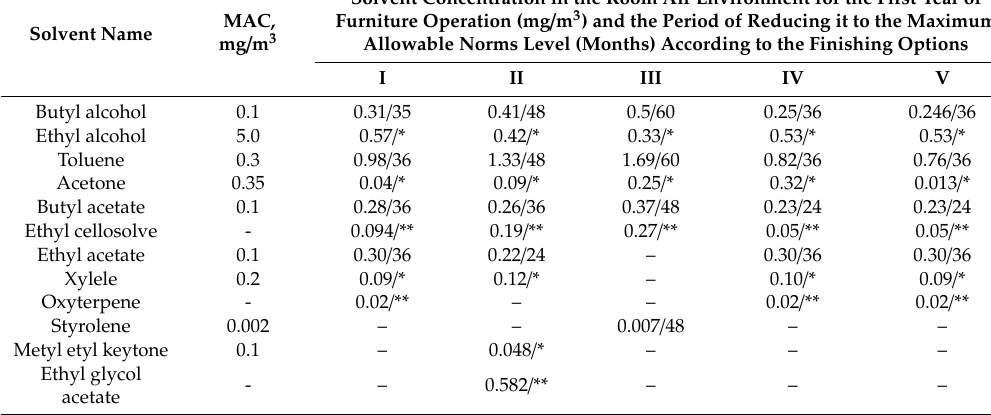
Table 3. The duration of the furniture operation, in which the concentration of solvent in the air environment of residential premises is reduced to the level of maximum permissible norms.